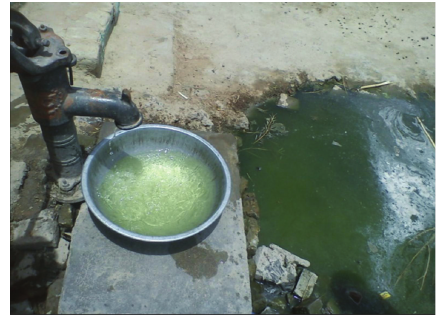
Figure 1: Photograph of yellow-colored contaminated water from a